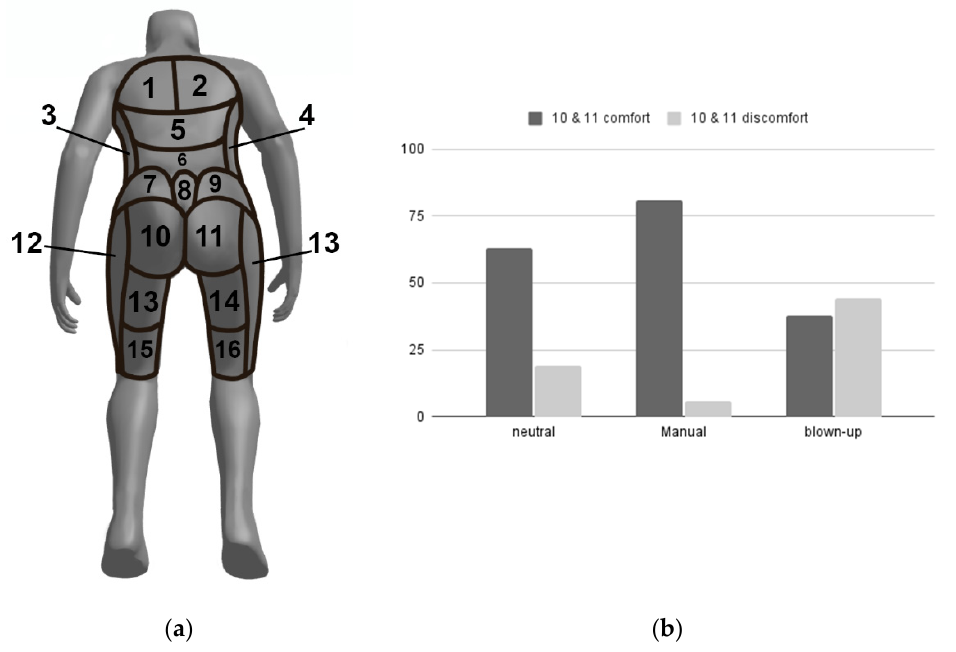
Figure 10. (Dis)comfort areas. (a) Body map for indicating the area of (dis)comfort. (b) Percentage of most (dis)comfort scores in the buttock area.